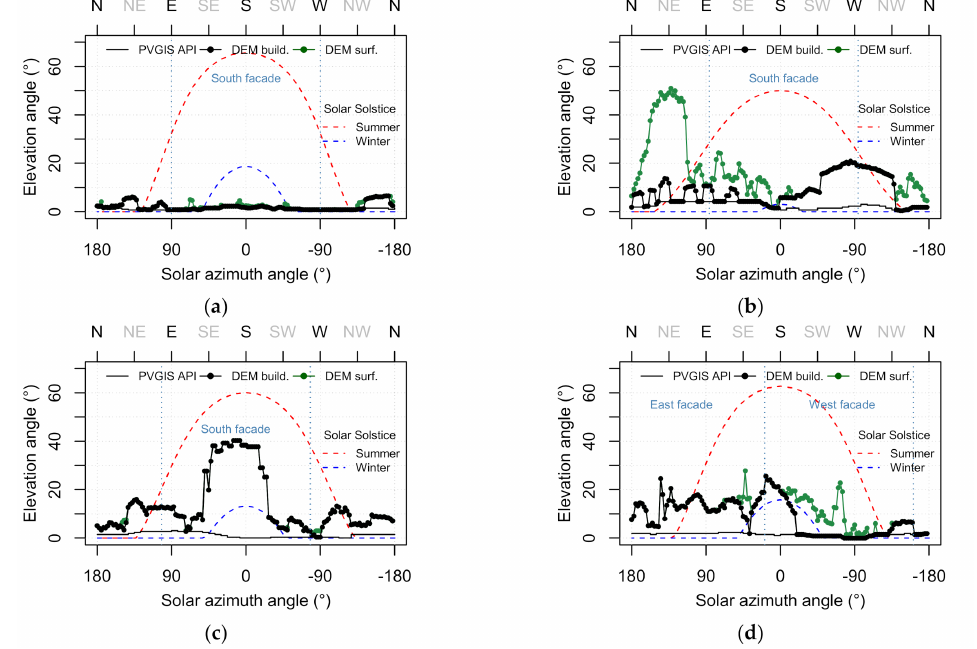
Figure 17. Calculated horizon angle at mid-façade height using the maximum local terrain pro- file of the PVGIS API (thin black line) and the digital elevation model DEM filtered to buildings only (thick black line) or without filter (green) for the ( a ) TWINS, ( b ) ZEBLL ( c ) GBORO and ( d ) UKULE